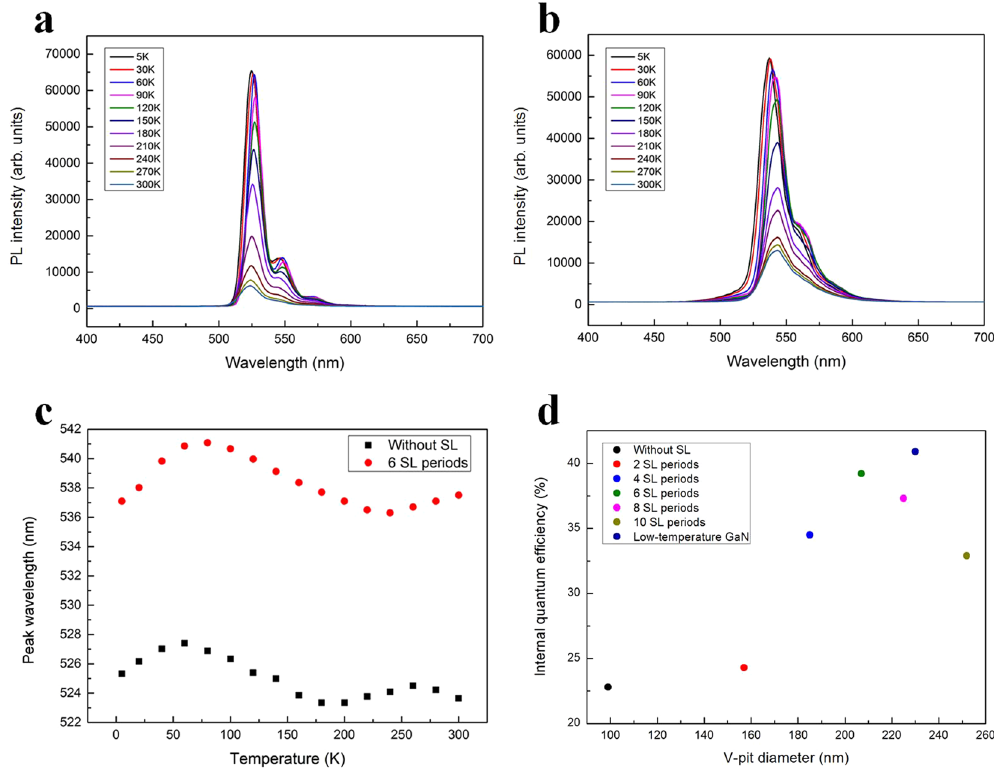
Figure 6. ( a ) Temperature-dependent PL spectra for green MQWs without an SL. ( b ) Temperature-dependent PL spectra for green MQWs grown on 6 SL periods. ( c ) Temperature-dependent peak wavelength of green LEDs without an SL and with 6 SL periods. ( d ) IQE of green MQWs grown on different numbers of SL periods as a function of the V-pit diameter. Variation of the IQE gives rise to the downward parabola. Among these green MQWs grown on various numbers of SL periods, the IQE of the green MQW grown on 6 SL periods is the highest. By replacing 6 periods of SL with low-temperature GaN, the IQE of the green LED is further